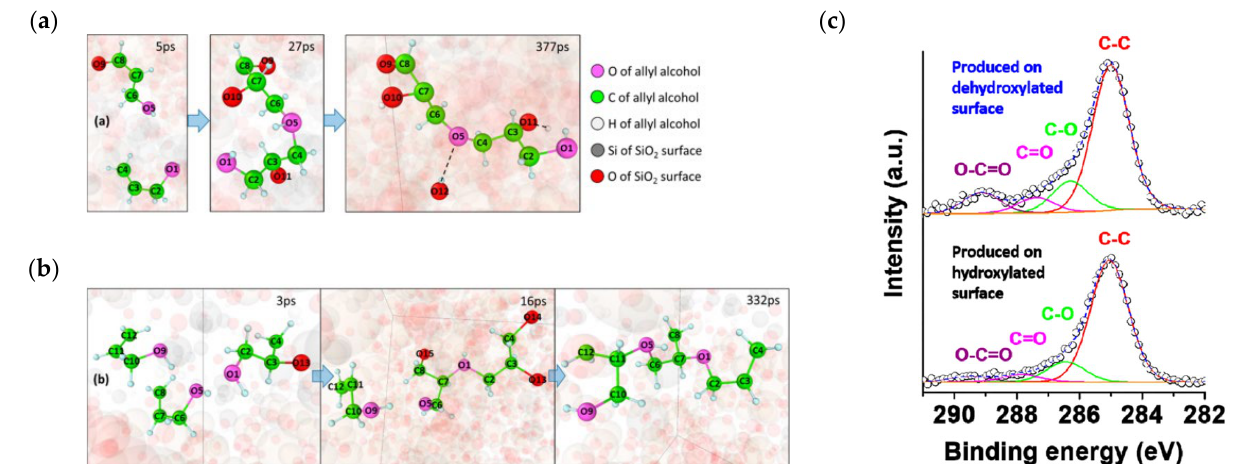
Figure 14. The ReaxFF simulation showing the association paths of ( a ) two and ( b ) three allyl alcohol molecules during sliding at the SiO 2 /SiO 2 interface (contact pressure = 1 GPa; slide speed = 10 m/s; temperature = 300 K) [88], Reprinted/adapted with permission from Ref. [88]. 2017, Applied Materials. and ( c ) C 1s XPS spectra of the shear-induced polymers produced on silicon oxide surfaces with two different surface conditions [89]. Reprinted/adapted with permission from Ref. [89]. 2018, Langmuir.